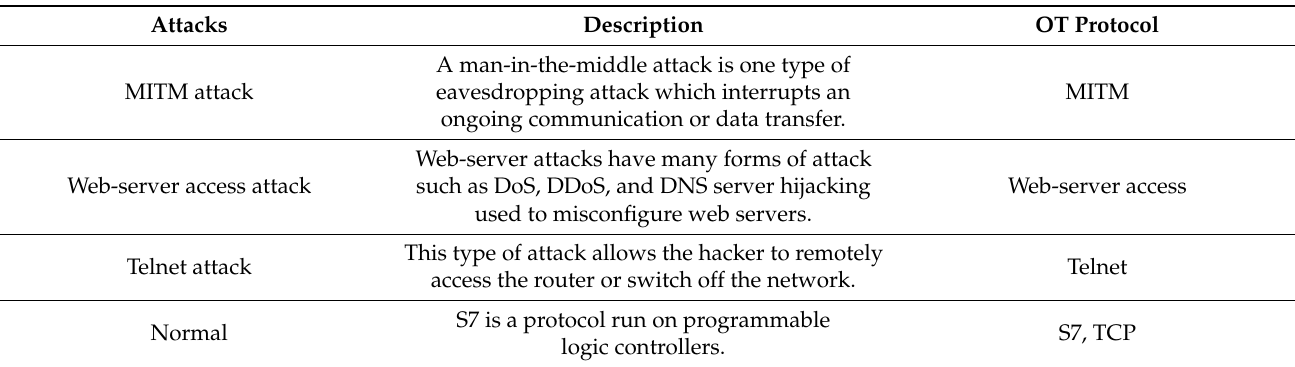
Table 1. Description of the dataset attacks.